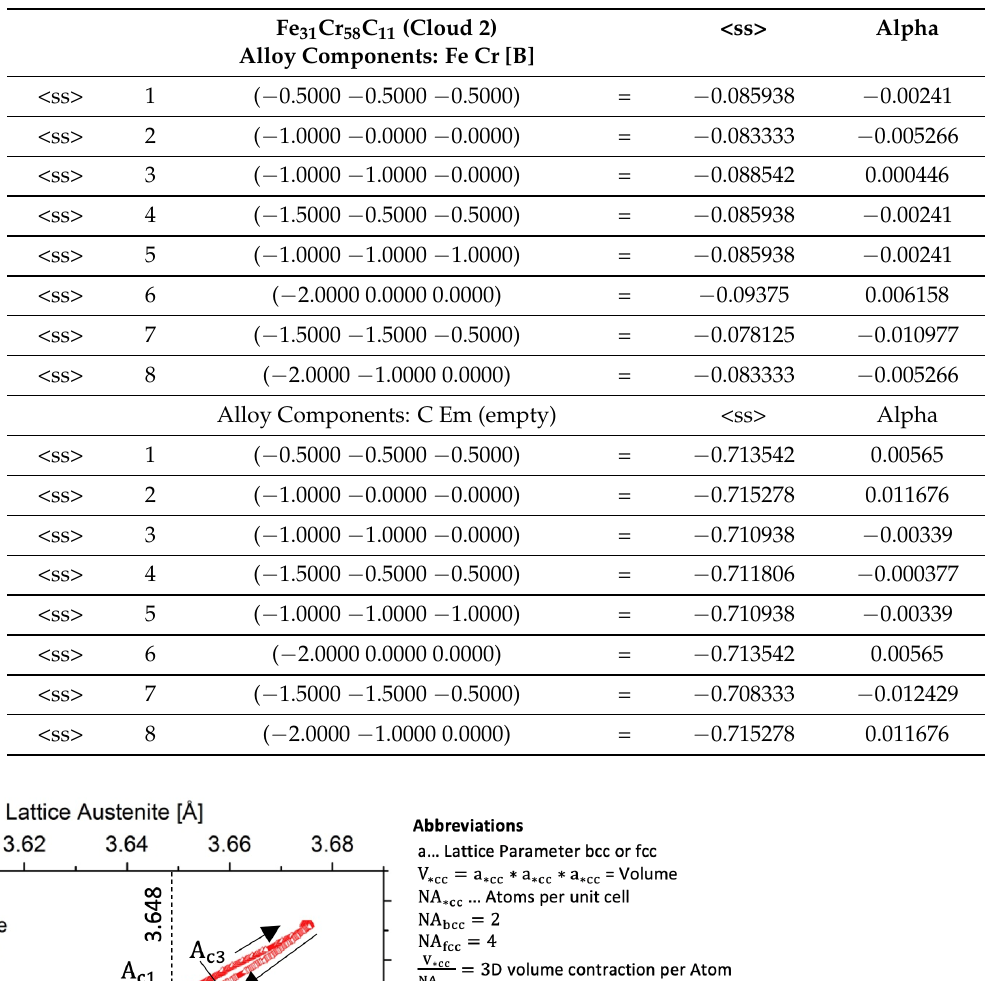
Table A4. CF for Cloud 2.